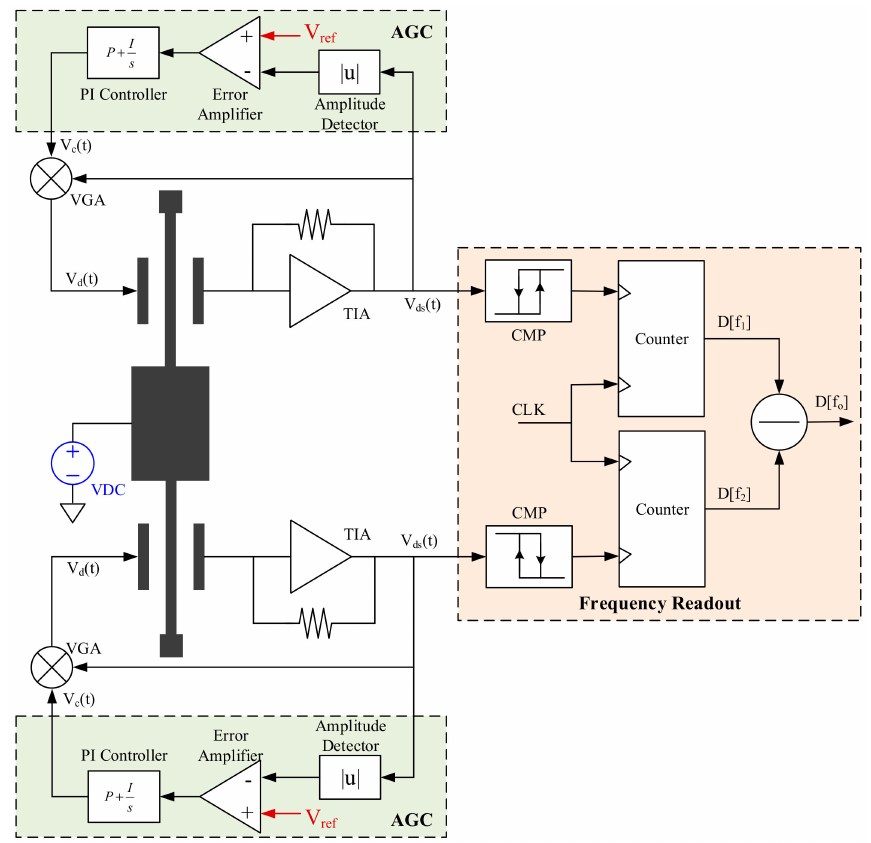
Figure 2. Block diagrams of a MEMS SOA oscillation loop and frequency readout